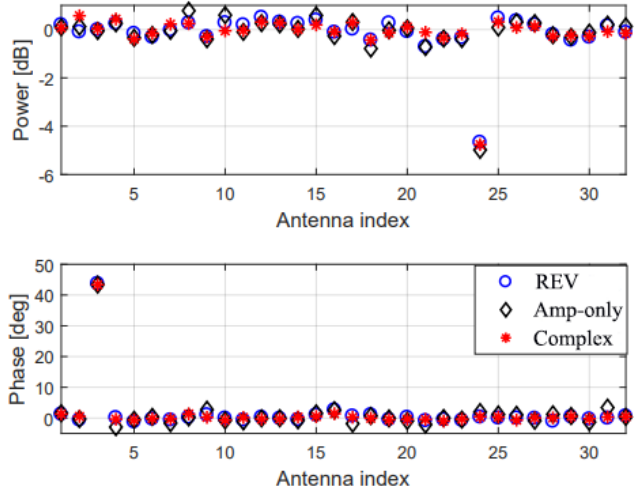
Figure 8. Array calibration results based on three methods with R = 1 m.